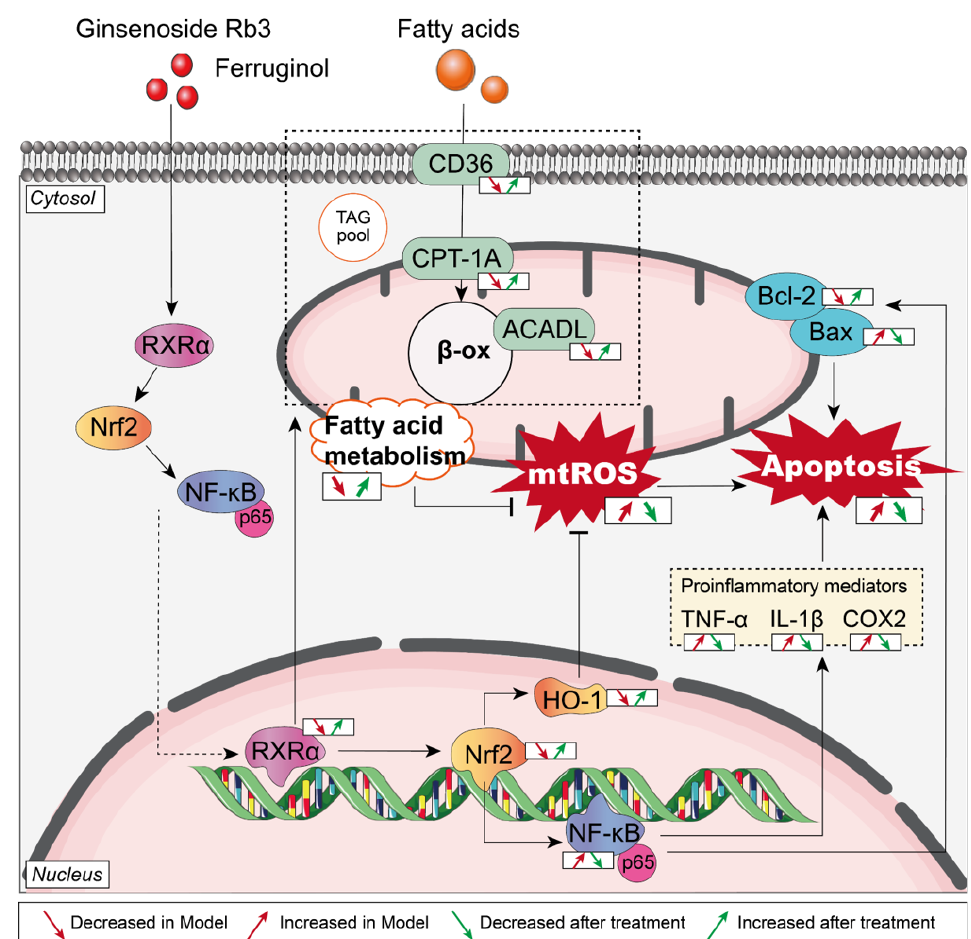
Figure 8. Mechanism of G-Rb3-FGL combination in the treatment of MI.